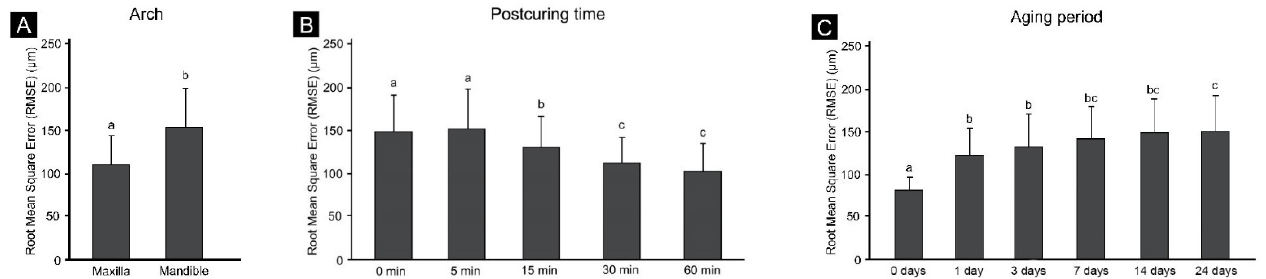
Figure 3. ( A ) Dimensional difference according to arch position, ( B ) dimensional difference after postcuring; and ( C ) dimensional difference, according to model aging period. Different lower-case letters indicate significant differences ( p < 0.05).